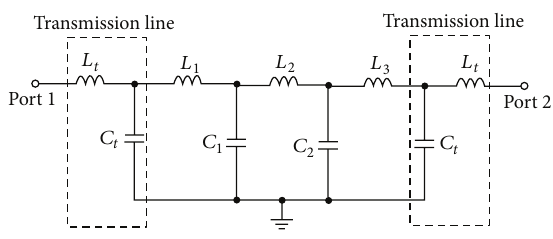
Figure 4: Equivalent circuit model of the asymmetric